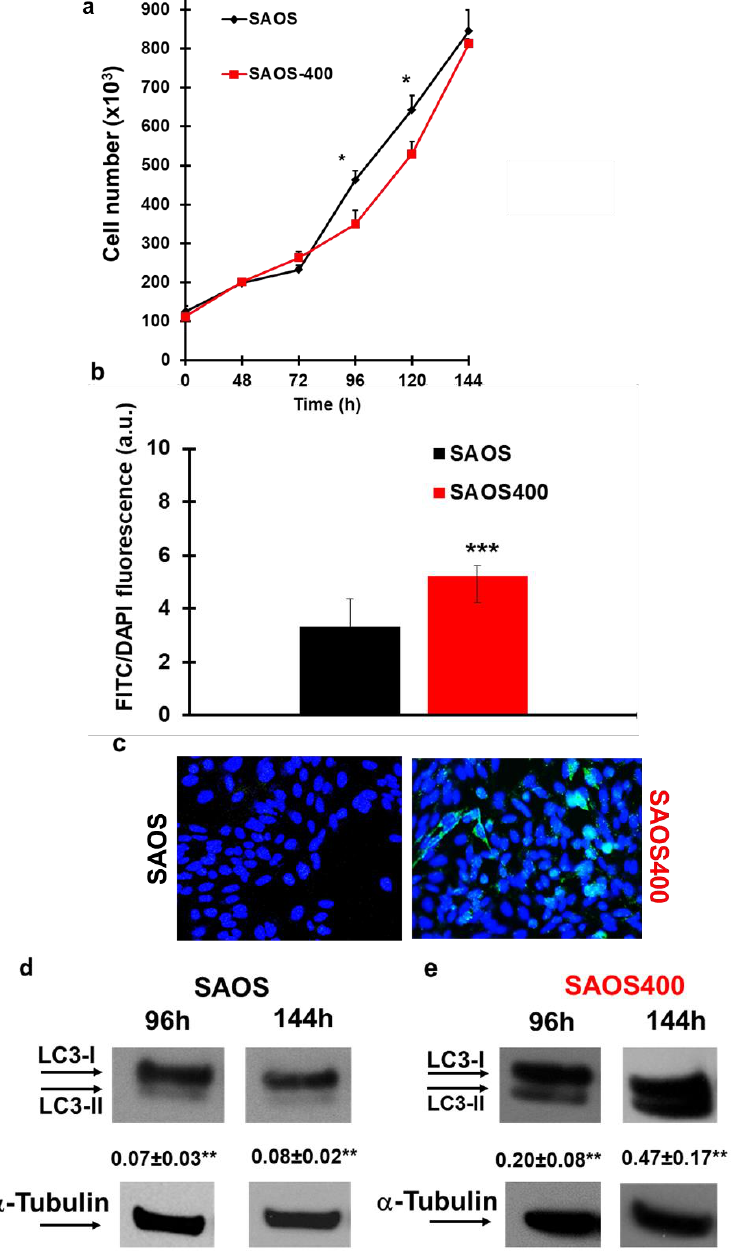
Figure 1. Panel ( a ): Proliferation curve of SAOS- and SAOS400-derived radioresistant cells. Cells were counted in duplicate at the indicated time points with Trypan blue stain using an automatic cell counter, as described. The mean of three experiments is shown ± SD. * p < 0.05 SAOS vs. SAOS400, Student’s t test. Panels ( b , c ): Comparison of the expression of autophagy markers in SAOS vs. SAOS400 cells. Cells were cultured for 96 h after autophagosome staining with Cyto-ID selective dye (FITC). The nuclei were stained with Hoechst dye, and the intracellular number was expressed as the FITC/DAPI ratio. The bar graphs ( b ) represent the mean ± SD, and symbols indicate significance: *** p < 0.001, with respect to SAOS. Representative photographs of untreated cells after Cyto-ID staining are reported in ( c ). Panels ( d , e ): Immunoblot analysis of the autophagy marker LC3I/II in SAOS and SAOS400 cells cultured at the indicated times. Densitometric analysis (numbers between panels indicate mean ± SD) was calculated by normalizing the expression of LC3-II with α -tubulin, as described in the Materials and Methods section (Section 4). Symbols indicate significance: ** p < 0.01 SAOS400 with respect to SAOS